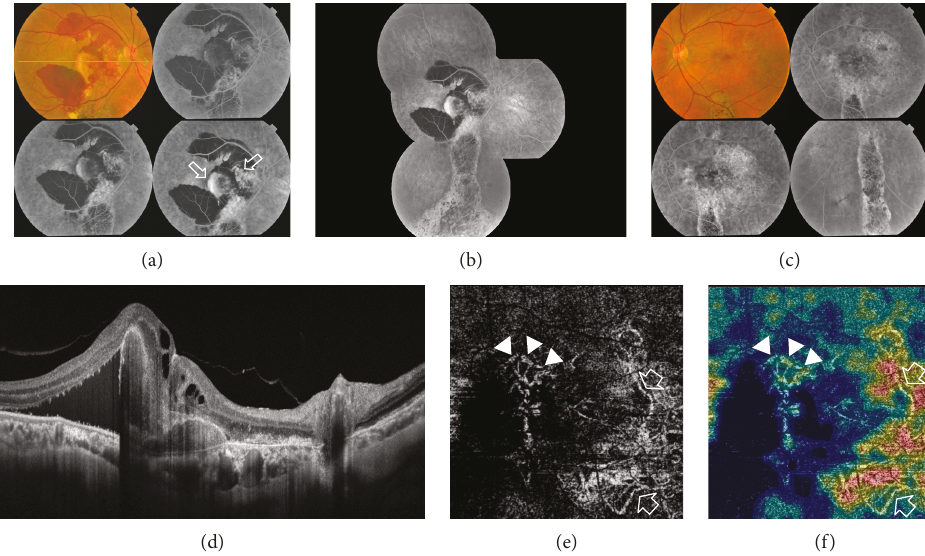
Figure 5: (a) The colored photo and FFA of the right eye of a 61-year-old male with bilateral chronic CSCR of approximately 2.5-year duration. The posterior pole shows a subretinal yellowish-white elevated lesion in the macular area measuring approximately 2 DD. The lesion is surrounded by extensive subretinal hemorrhage that extends beyond the temporal vascular arcades. On FFA, there were two distinct patterns of hyper fl uorescence. The fi rst pattern corresponded to the yellowish-white lesion seen in the colored photo and consisted of early hyper fl uorescence that gradually increased in intensity due to pooling into PED. The second pattern consisted of early stippled hyper fl uorescence that increased in intensity throughout the angiogram resulting in an ill-de fi ned hyper fl uorescent area (open arrows). Note the blocked fl uorescence corresponding to subretinal hemorrhage in the colored photo. (b) The composite FFA of the right eye shows extensive retinal pigment epitheliopathy in the macular area, extending inferiorly due to gravitation of subretinal fl uid giving rise to the characteristic teardrop sign (atrophic RPE track). (c) The colored photo and FFA of the left eye showing di ff use retinal pigment epitheliopathy and the characteristic teardrop sign. (d) The radial scan SS-OCT of the right eye demonstrates neurosensory detachment along with subretinal hyperre fl ective heterogeneous material, sizeable subfoveal PED, and sub-RPE hyperre fl ective material. (e) The SS- OCTA of the right eye at the level of the outer retina in a 4.5mm × 4.5mm fi eld revealed the characteristic hyperintense signal of a subfoveal neovascular complex composed of a main trunk with branching smaller vessels each terminating in polyp-like con fi guration reminiscent of PCV (arrow heads). In addition, there was another juxtapapillary larger neovascular complex composed of dense capillary arborization. At least two feeder vessels could be identi fi ed (open arrows). (f) The corresponding color-coded density map re fl ecting blood fl ow at the level of the outer retina. Note the intense red signal denoting high fl ow within the neovascular complexes seen, contrasting with the blue background typical of avascular outer